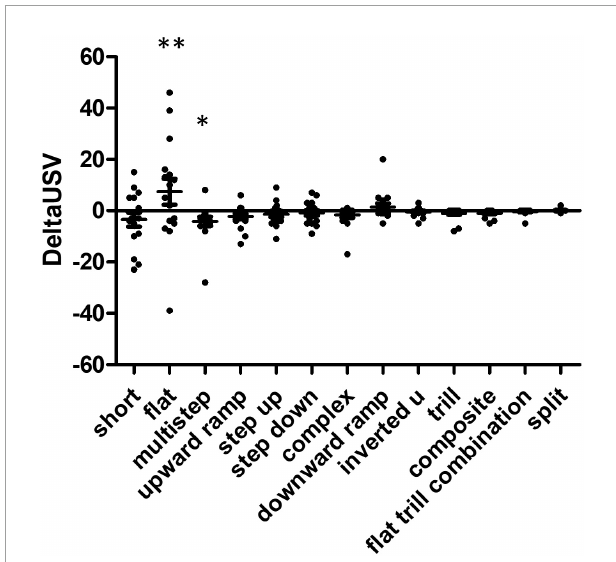
FIGURE4 Comparison of USV production in food consumption phase reveals over-representation of specific USV subtypes. Delta USV calculations were performed for each USV subtype and each rat. Statistical analysis reveals significant differences between food anticipation and consumption phases (Kruskall Wallis W = 23.88, p = 0.0211), some USVs were over- or under-represented in the food consumption phase, compared to the anticipatory phase. The post hoc Dunn’s multiple comparison test allowed the identification of significantly different USV subtypes, these are indicated by asterisks on the graph: flat vs. multistep ( ∗∗ p < 0.01) and multistep vs. trill ( ∗ p < 0.05) N = 16